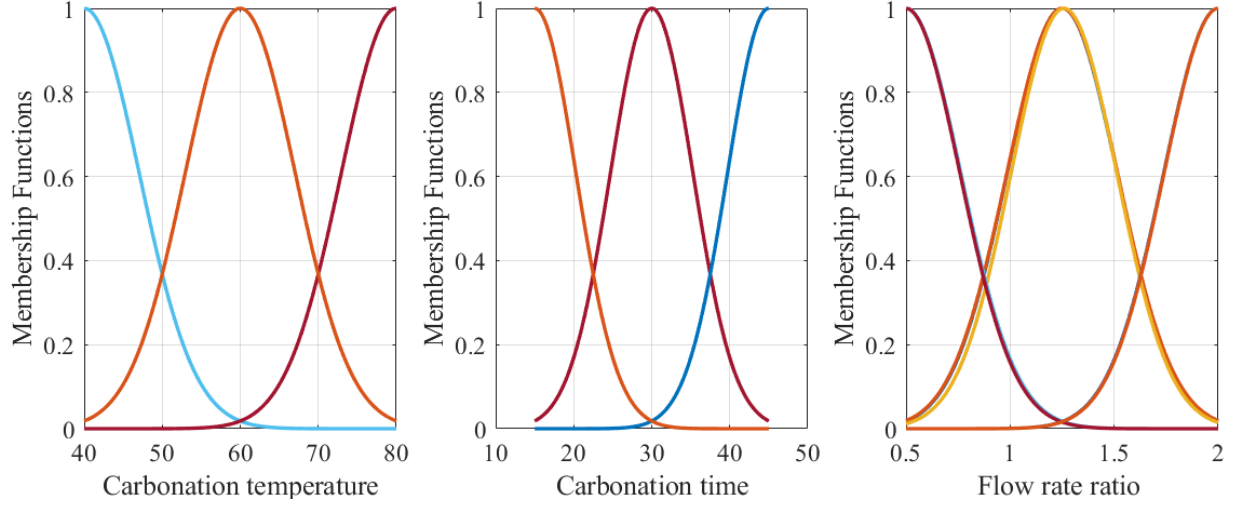
Figure 3. Membership functions of the fuzzy model of the CO 2 capture process.